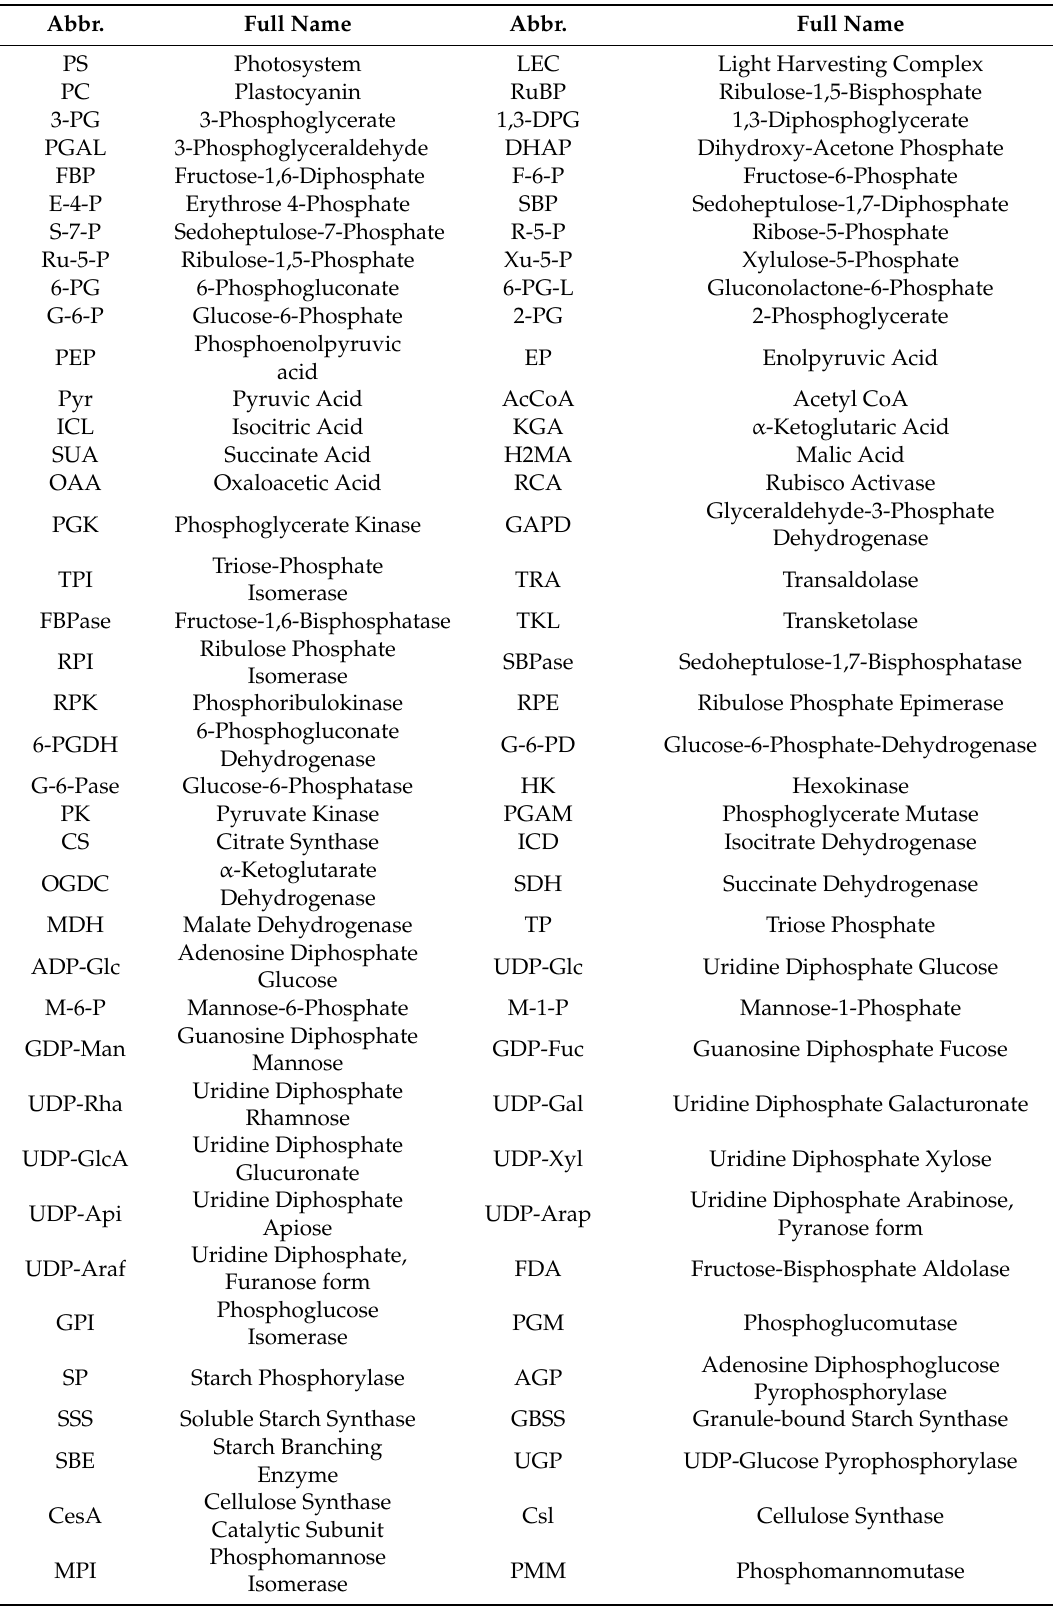
Table A2. Abbreviation in this